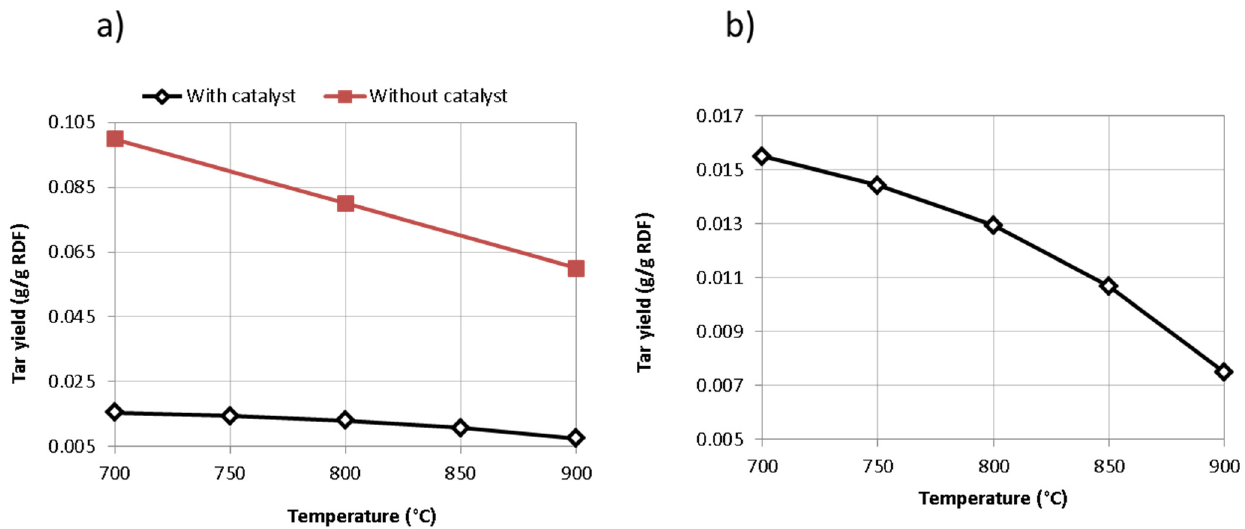
Figure 6. Tar yield from RDF gasification with a secondary catalytic stage with Ni-doped clay catalyst. ( a ) Comparison with non catalytic process, ( b ) Effect of temperature.